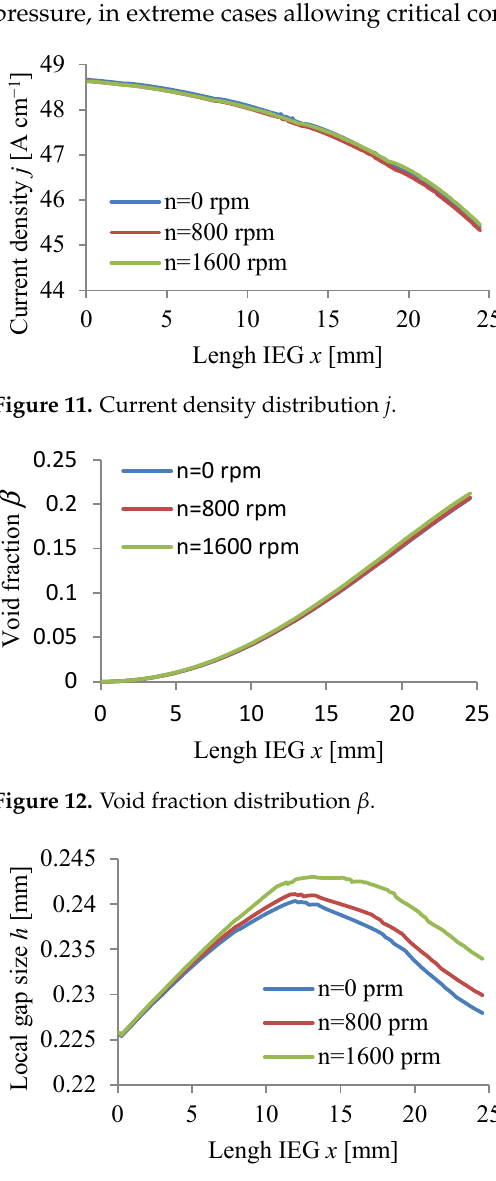
Figure 10. Temperature distribution 𝑇 .